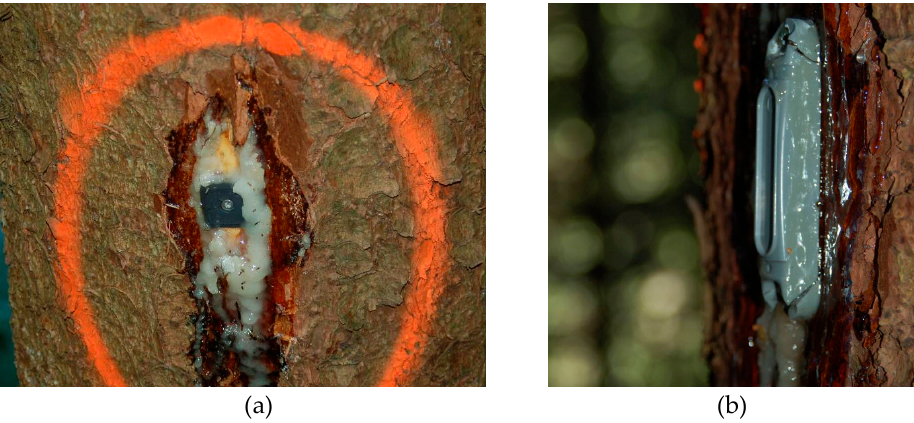
Figure 3. ( a ) CIM model and ( b ) OE model after 2 years. Note the cracks on the case of OE tag.